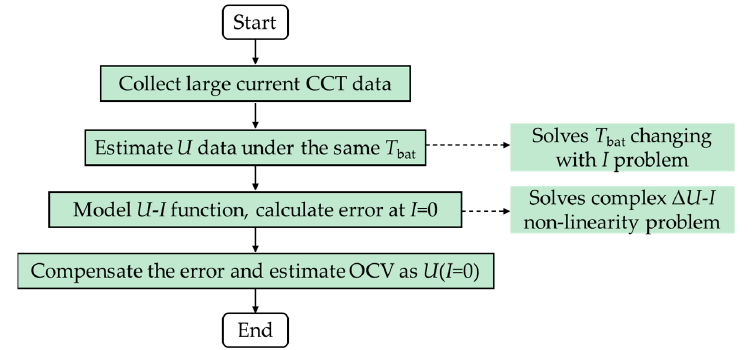
Figure 6. Schematic flow chart of the proposed method.